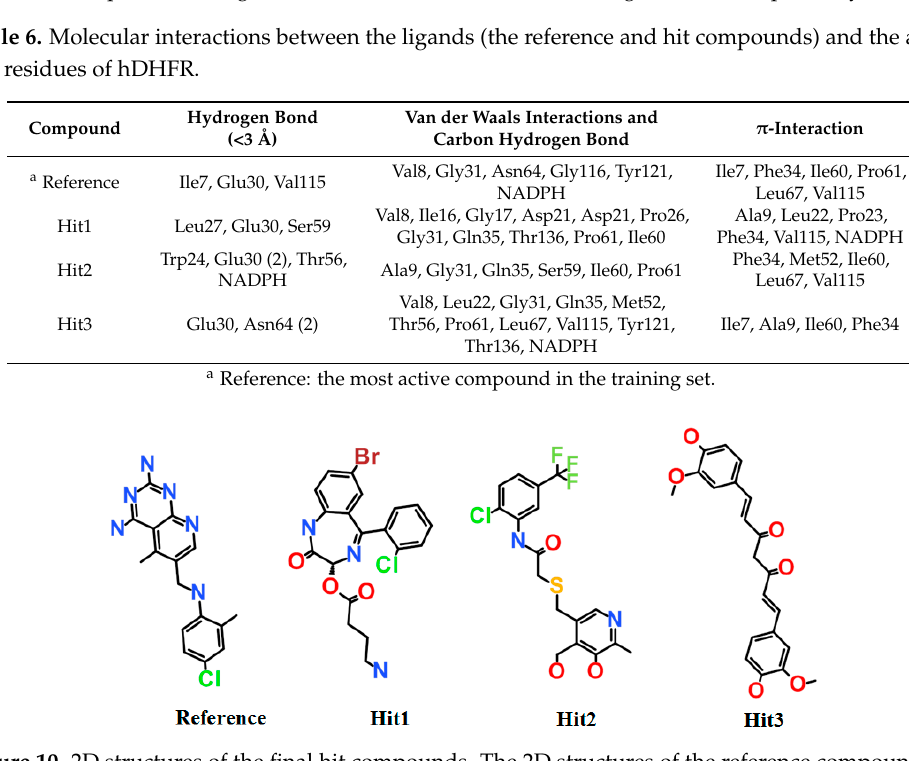
Figure 10. 2D structures of the final hit compounds. The 2D structures of the reference compound ( A ), Hit1 ( B ), Hit2 ( C ), and Hit3 ( D ) are depicted.